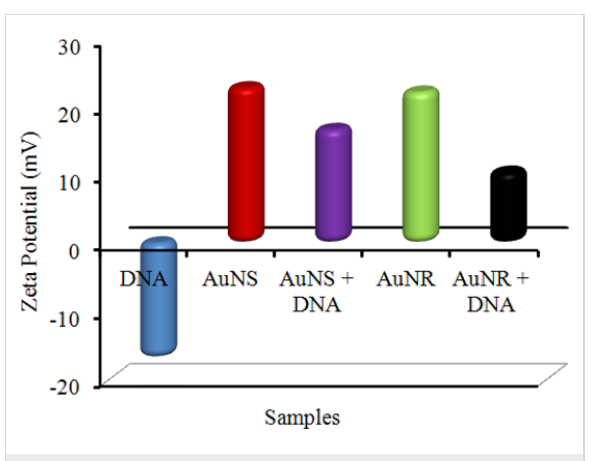
Figure 7: Variation in zeta potential of AuNPs before and after DNA modification.